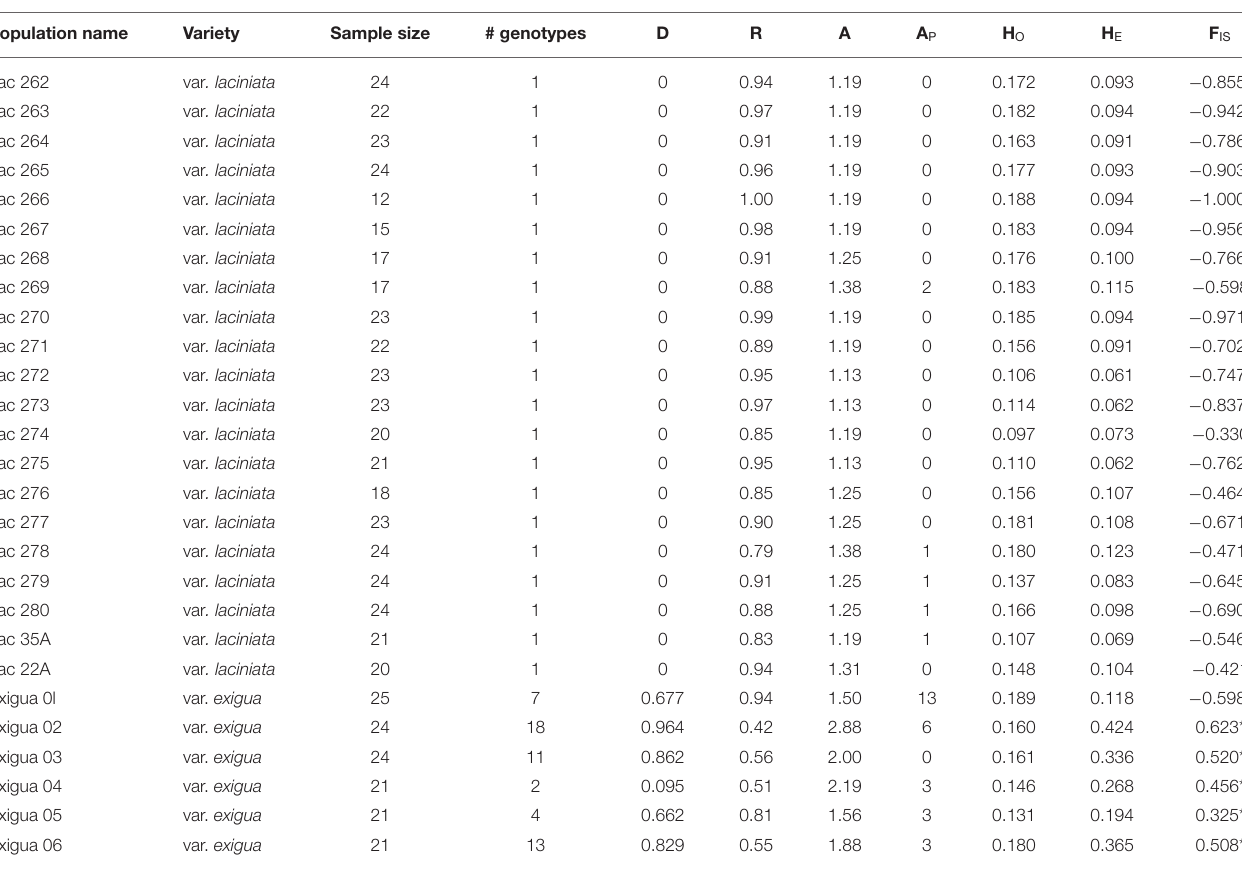
TABLE 3 | Levels of genetic diversity in sampled populations of Leavenworthia exigua , including number of sampled individuals per population, number of genotypes found in each population, clonal diversity (D), mean relatedness among individuals within a population (R), average number of alleles (A), private alleles (A P ) observed, and expected heterozygosity (H O and H E , respectively), the inbreeding coefficient (F IS